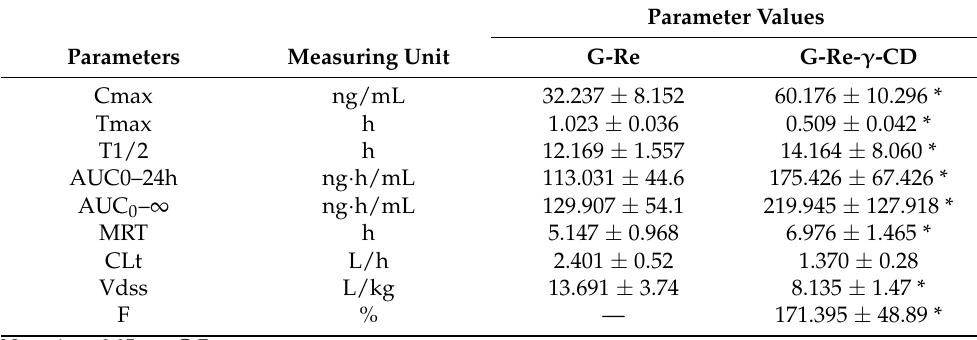
Table 3. Main pharmacokinetic parameters of G-Re and G-Re- γ -CD IC after single oral administration in rats (mean ± SD, n =